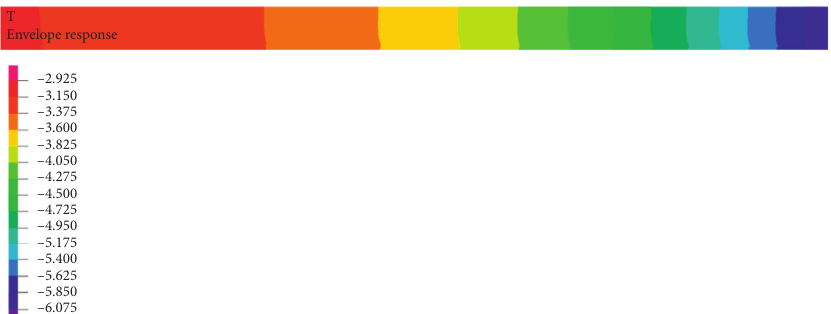
Figure 18: Annual average air temperature distribution in the tunnel axis with a thermal conductivity of 0.03W/(m · °